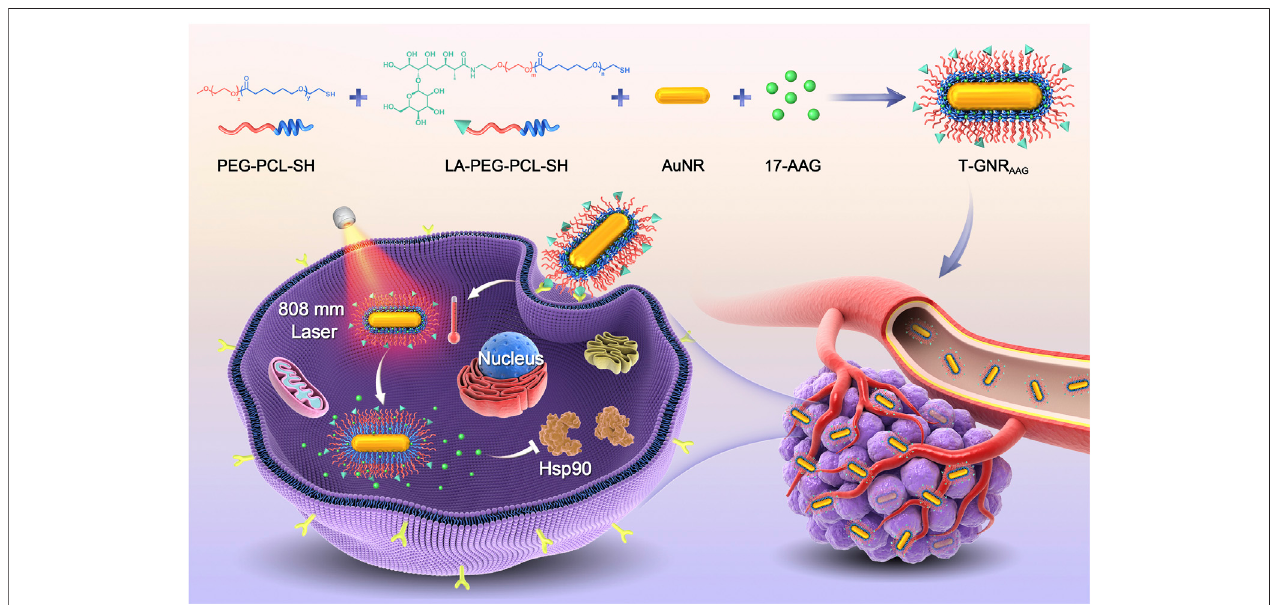
FIGURE 1 | Scheme of LA-targeted drug delivery and 808 nm laser-triggered AAG release for combined chemo-PTT.